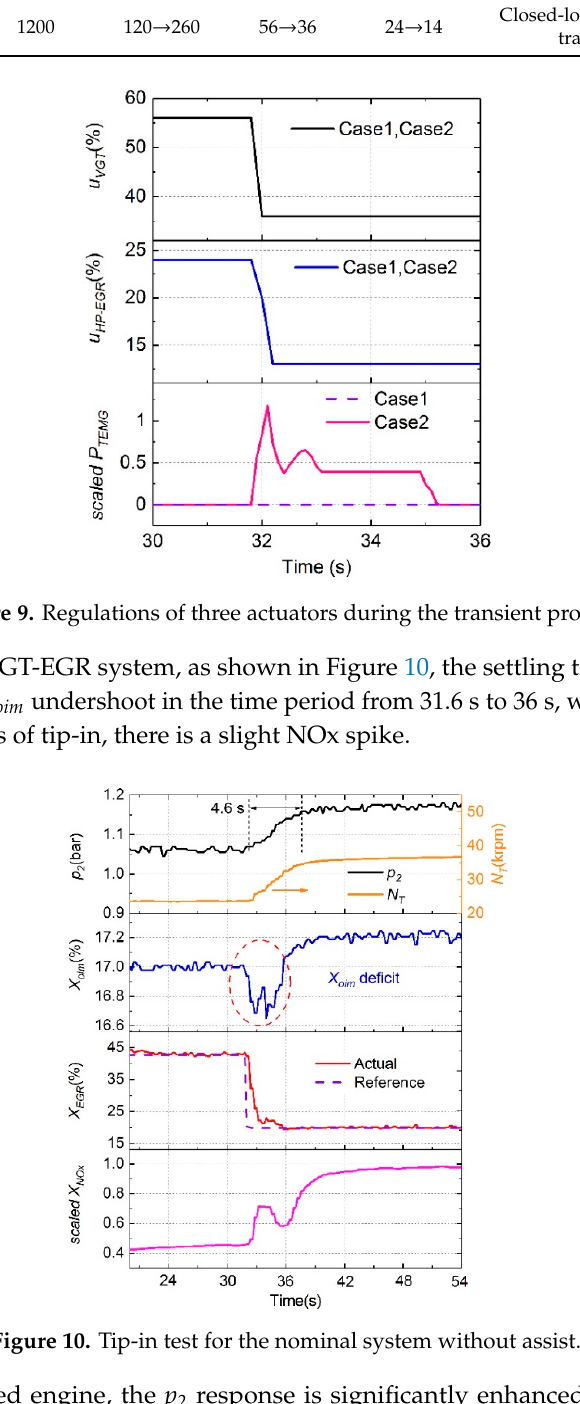
Figure 11. Tip-in test for the EAT system